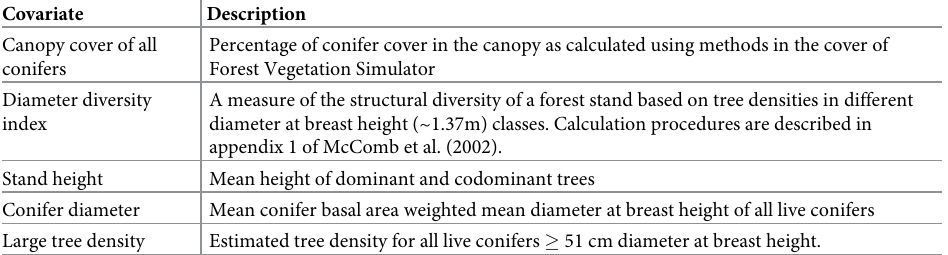
Table 1. Forest structure covariates used with MaxEnt modeling software v3.3 [55] to estimate probability of pres- ence within modeling regions occupied by both Humboldt martens and spotted owls. Data from Davis, Hollen, [7] using Gradient Nearest Neighbor vegetation data, incorporating remotely sensed Landsat imagery and ground-based plot (Forest Inventory Analysis) updated in 2012